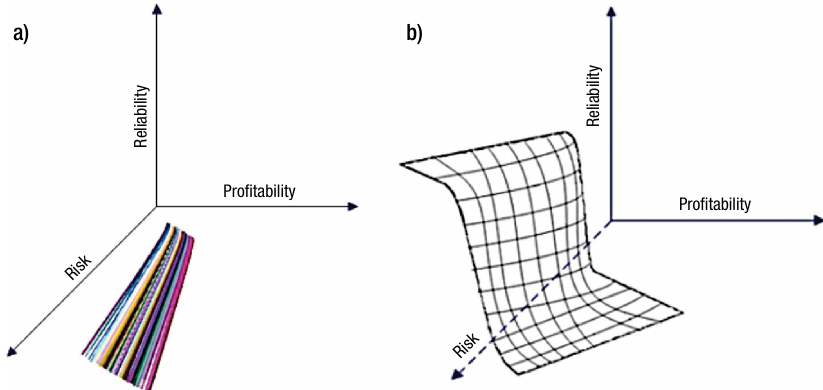
Fig. 2. Schematic view of efficient surface formation: a) rotation of efficient